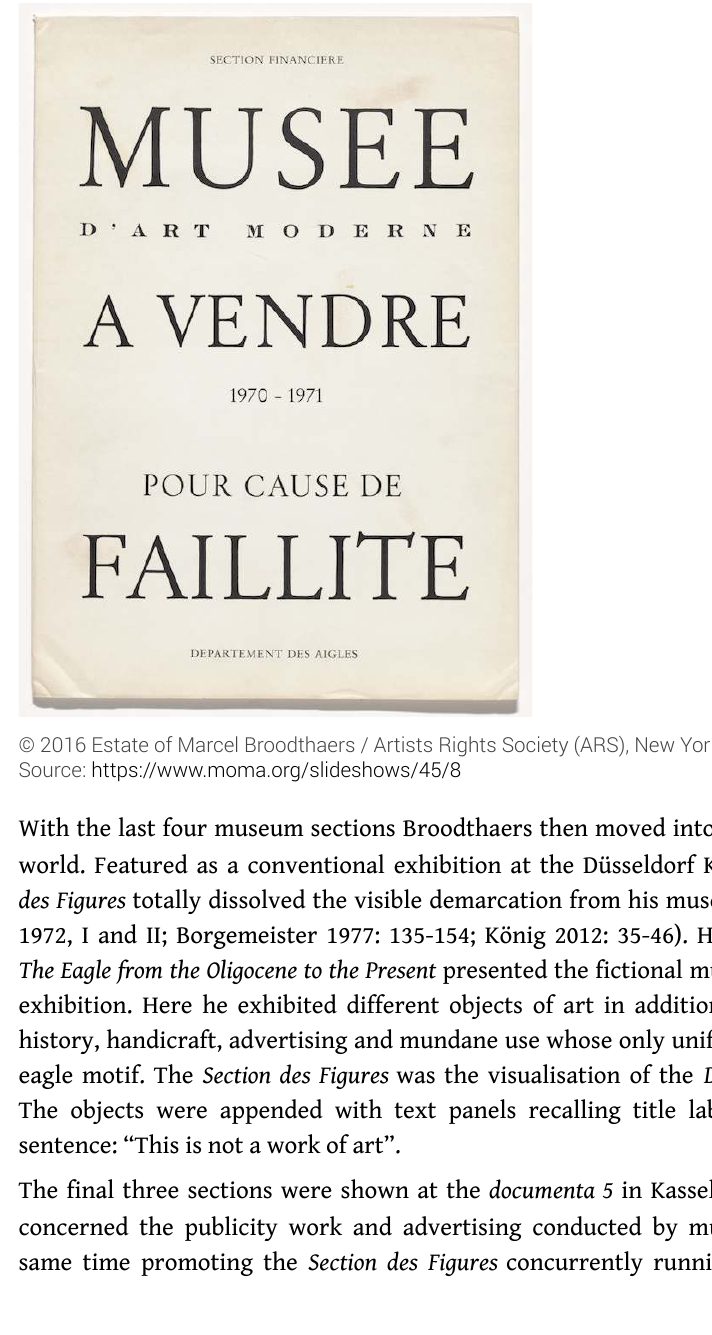
Figure 1: Marcel Broodthaers, Musée d’Art Moderne à vendre – pour cause de faillite (Museum of Modern Art for sale – due to bankruptcy), 1970-71